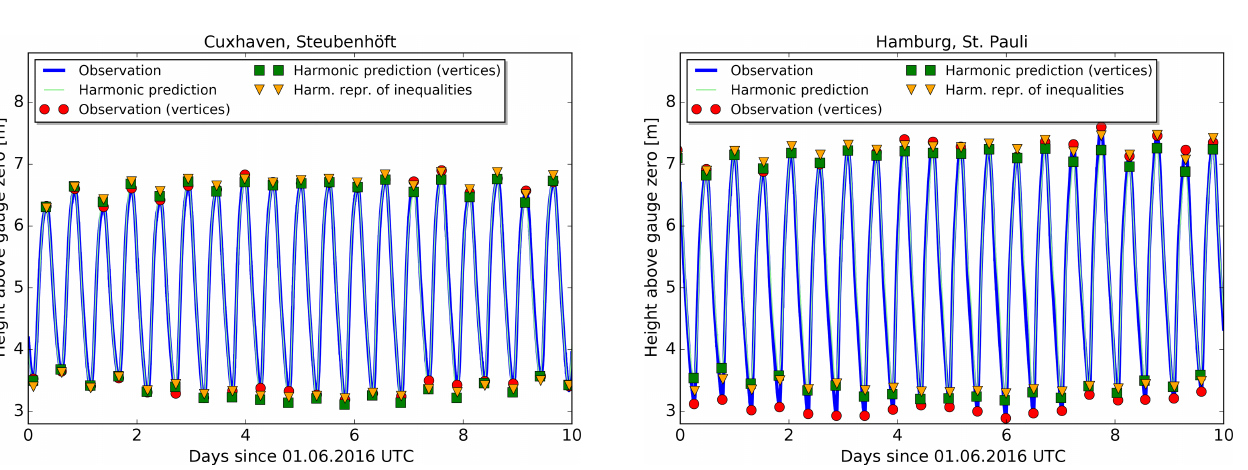
Figure 13. Observations and two predictions for the tide gauge Hamburg, St. Pauli. The first 10d of June 2016 are shown. Table 7. Residuals of predicted and observed times and heights of high and low water: mean µ and standard deviation σ